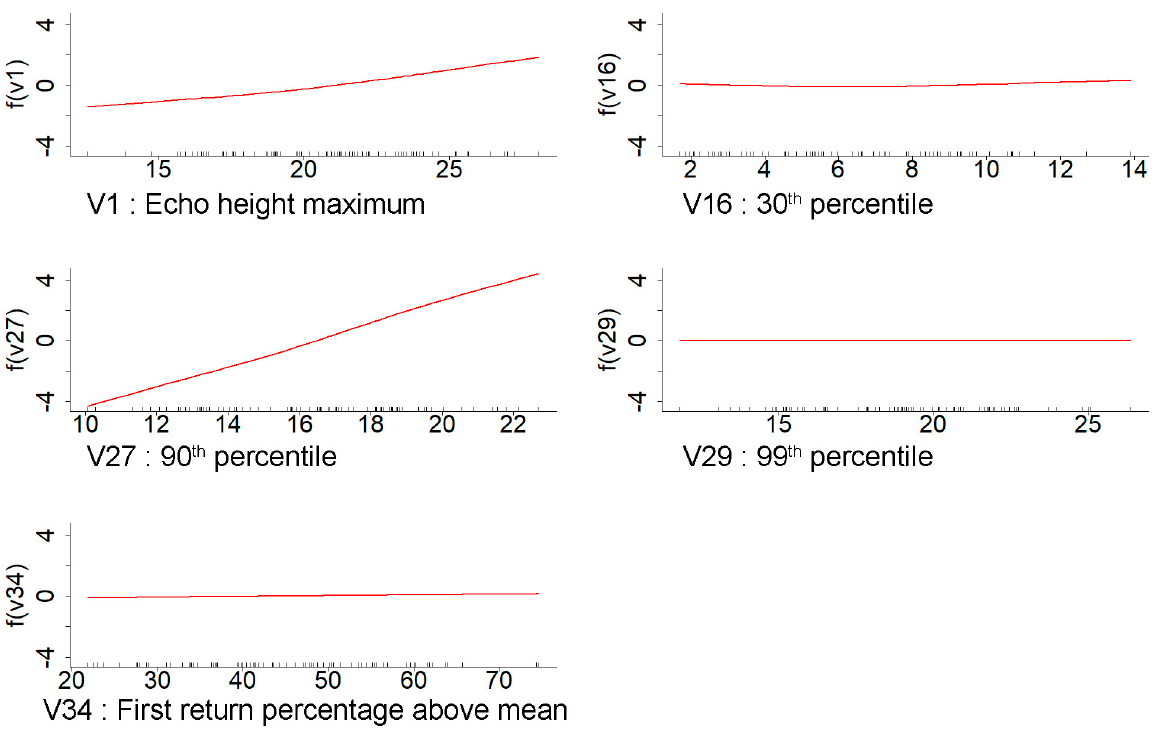
Figure 7. Each panel shows the relationship of the variable with nonzero coefficients (X-axis) in the GAMSEL model for dominant height estimation with the functions for the last value of the lambda (Y-axis).